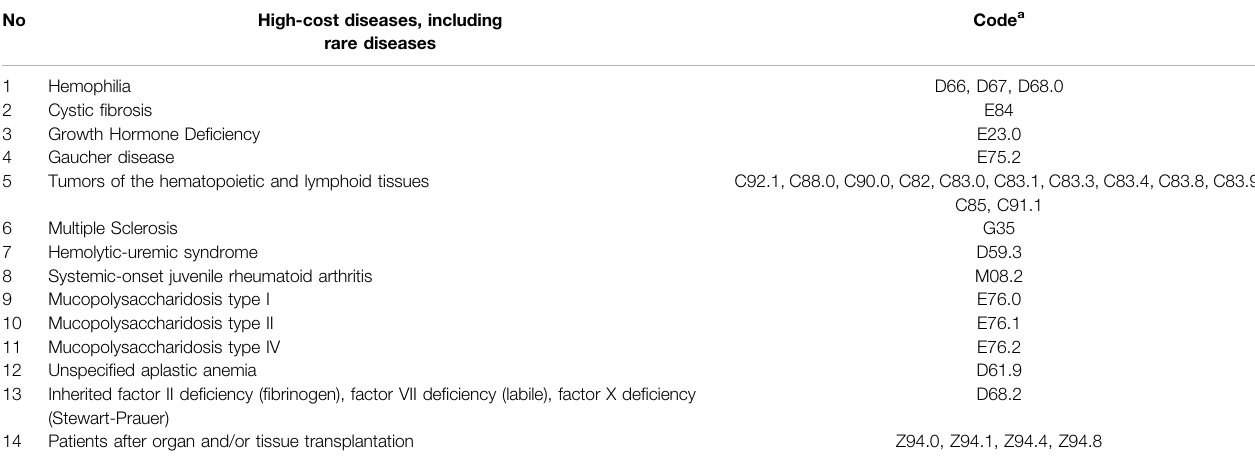
TABLE 1 | Federal list of high-cost diseases, including rare